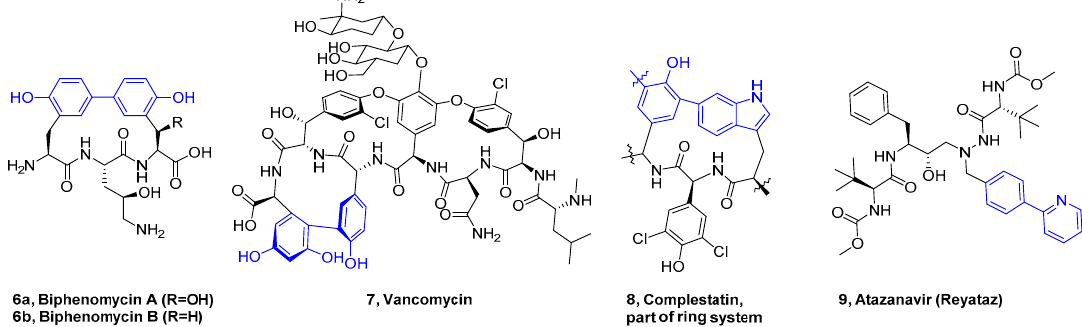
Figure 2. Naturally occurring peptides 6 – 8 and anti-retroviral drug Atazanavir 9 containing a Figure 1. Naturally occurring peptides 6 – 8 and anti-retroviral drug Atazanavir 9 biaryl containing a biaryl moiety.